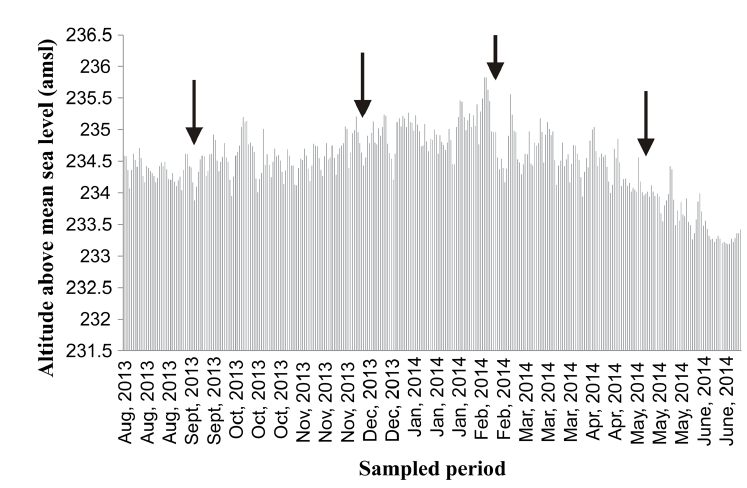
Figure 2. Variation in water level in relation to sea level (amsl) from August 2013 to July 2014. Areas signed with arrows represent sampled months. The value zero in the y-axis is represented by 231.5 (level zero corrected by altitude above mean sea level).